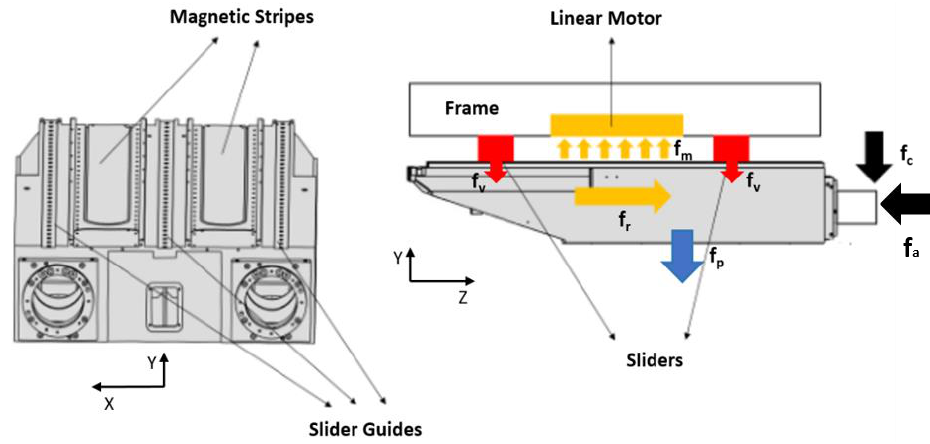
Figure 1. Z-axis carriage.